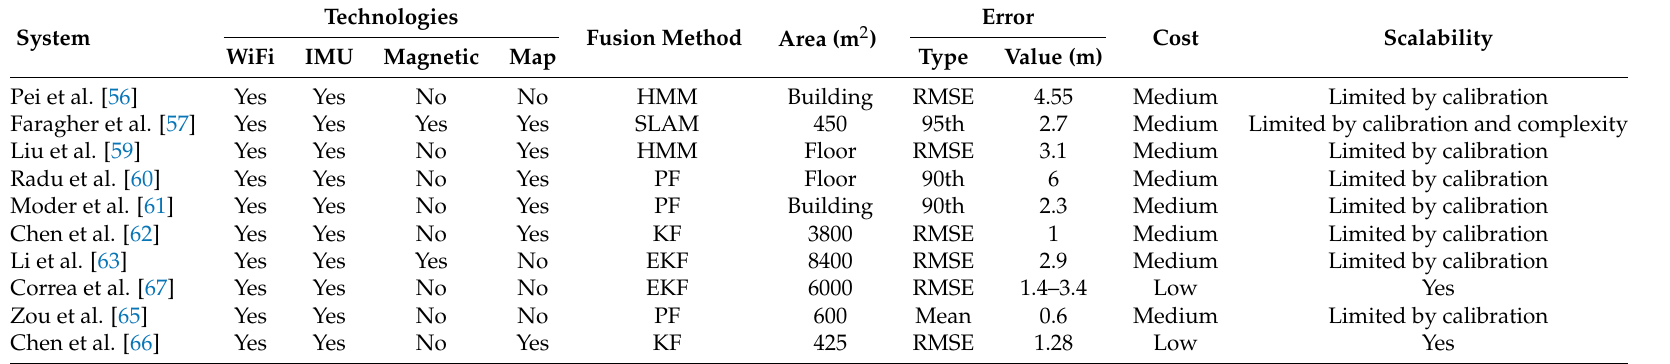
Table 5. Smartphone positioning